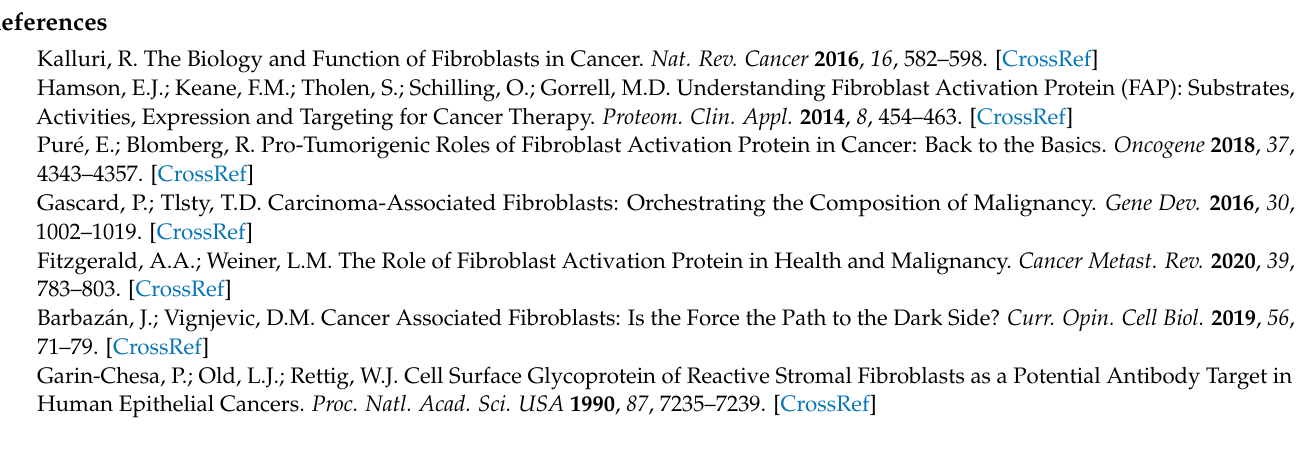
Table S3 (‘high-tumor burden’ only, n = 25): Descriptive statistics of uptake in normal organs and tumor lesions. Table S4 (‘high tumor burden’ only, n = 25). Correlation (Spearman’s Rho, ρ ) to determine associations between radiotracer uptake in normal organs and tumor